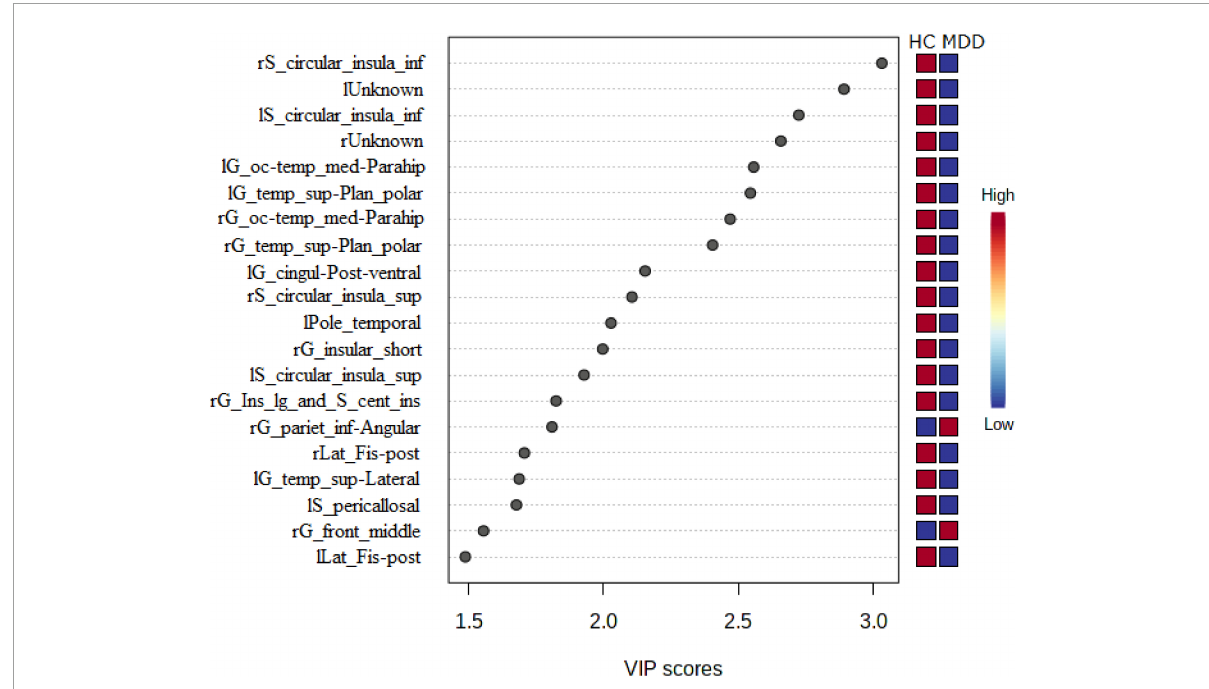
FIGURE4 Relationship between expressed LGIs in MDD and HC groups. We showed the 20 significant features of differently expressed LGIs (VIP > 1.5) in MDD and HC groups. “l” and “r” attached to the beginning of the word mean “left” and